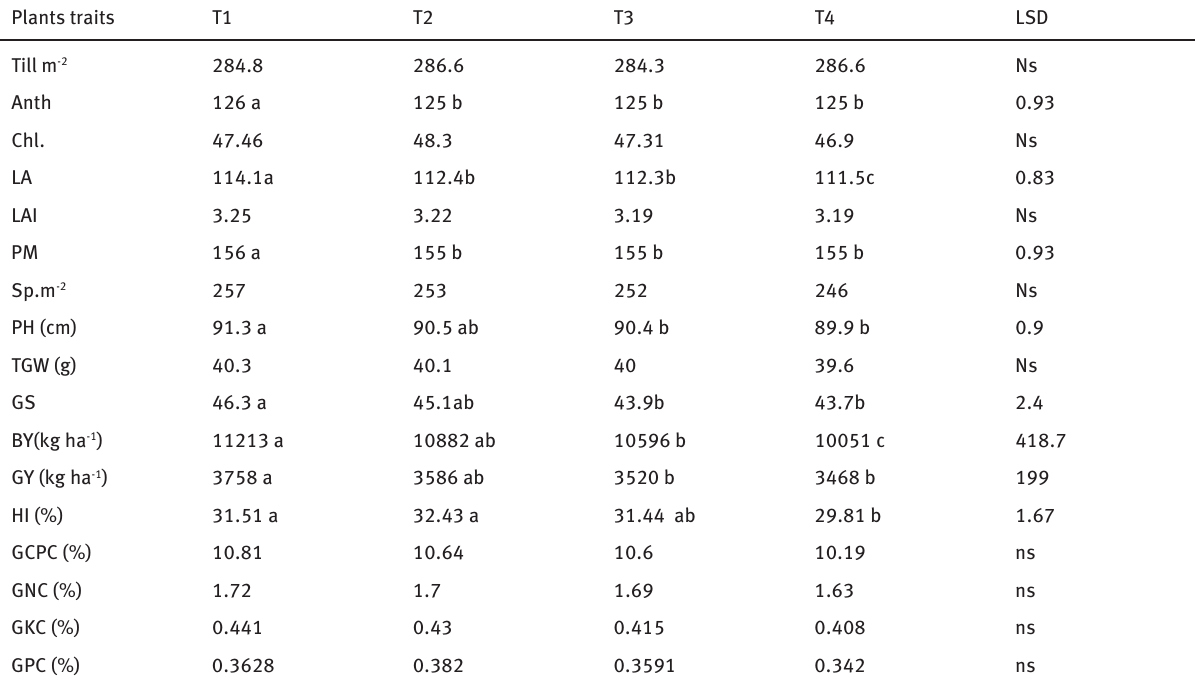
Table 3: Phonological, physiological, yield, yield components and grain nutrients contents of wheat as influenced by K application timings Plants traits T1